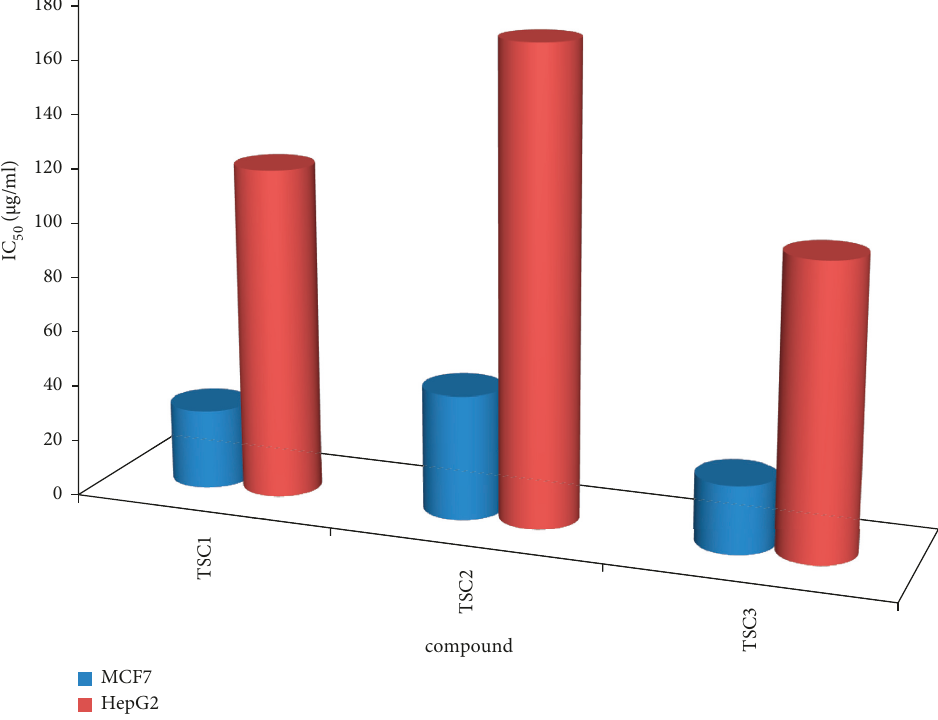
Figure 4: Cytotoxicity of TSC1, TSC2, and TSC3 on breast and liver cancer cell lines. Table 5: Protonation constants for TSC1 ligand at different